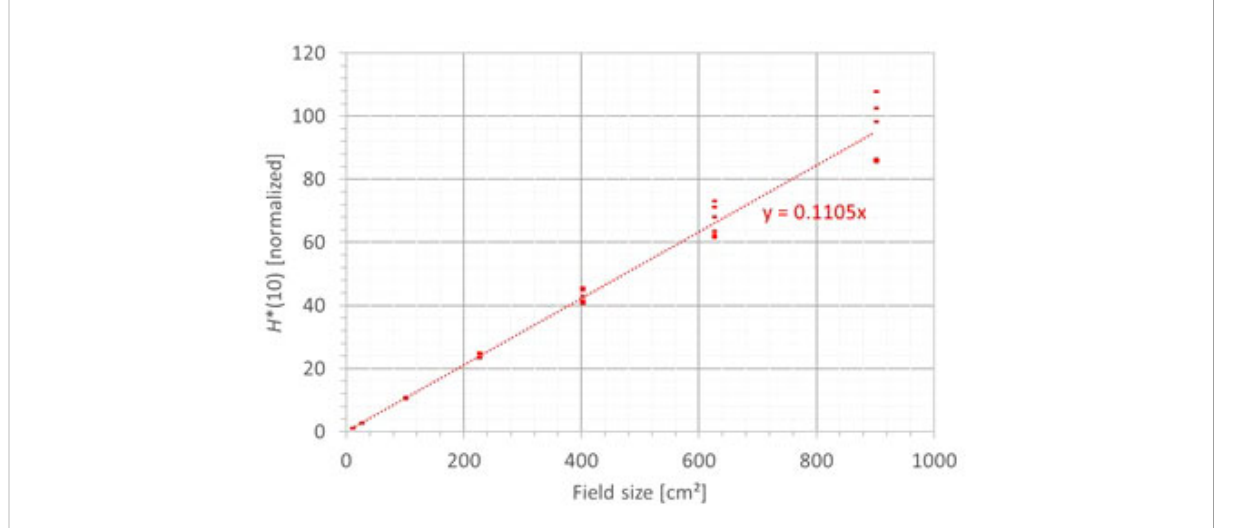
FIGURE 10 Plot of the variation of the simulated H*(10) as a function of the fi eld size for all positions for a range of 15 cm and a modulation width of 10 cm without a range shifter with a linear fi t through all the data